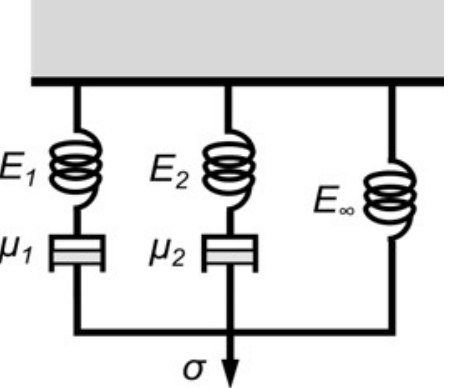
Figure 5. A Maxwell-Wiechert model with two branches ( N =